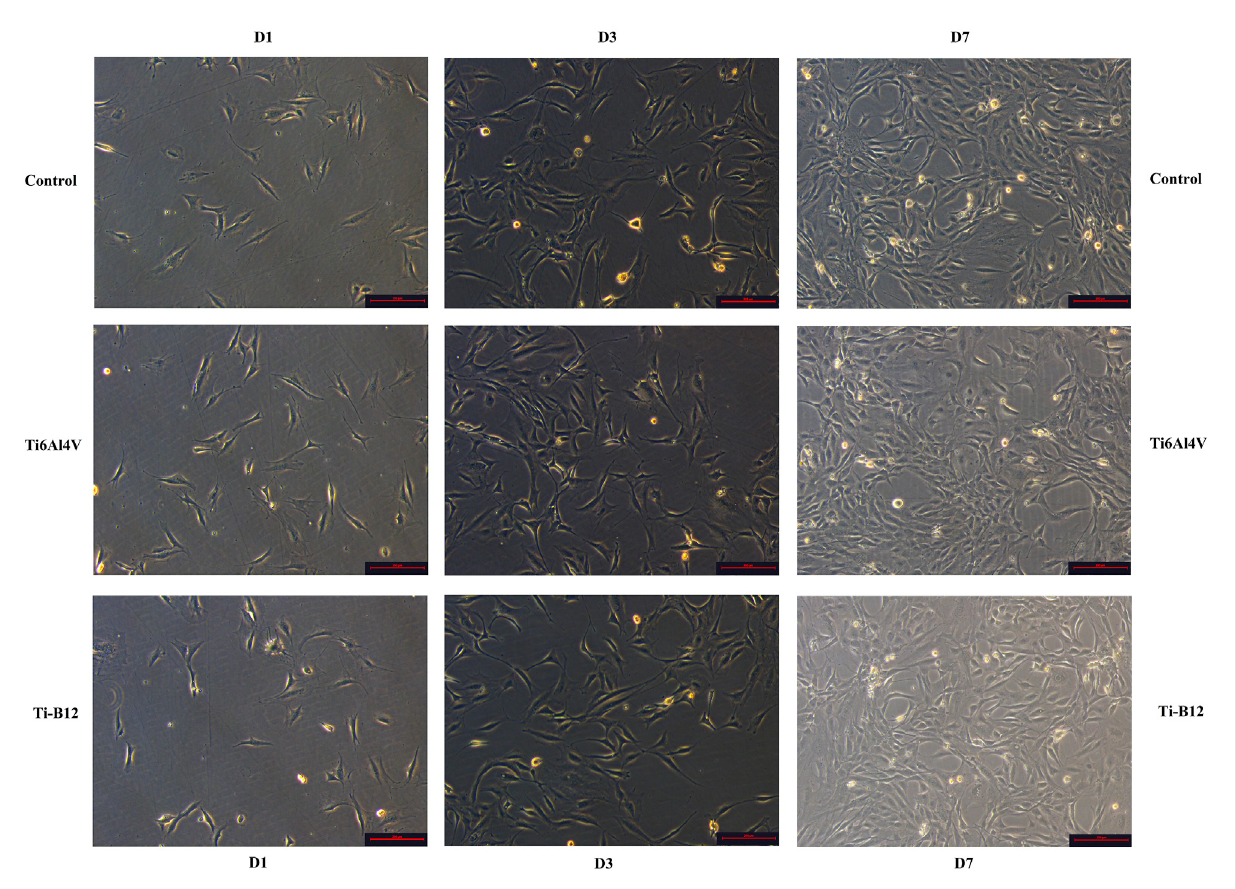
FIGURE 3 MC3T3-E1 Cell morphology observation of three groups on the 1 st , 3 rd , and 7 th